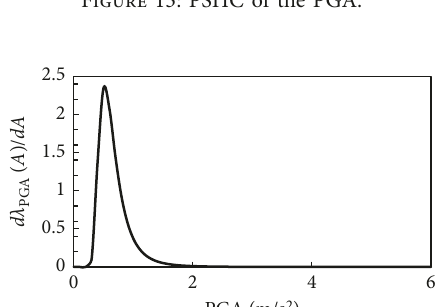
Figure 13: PSHC of the PGA.